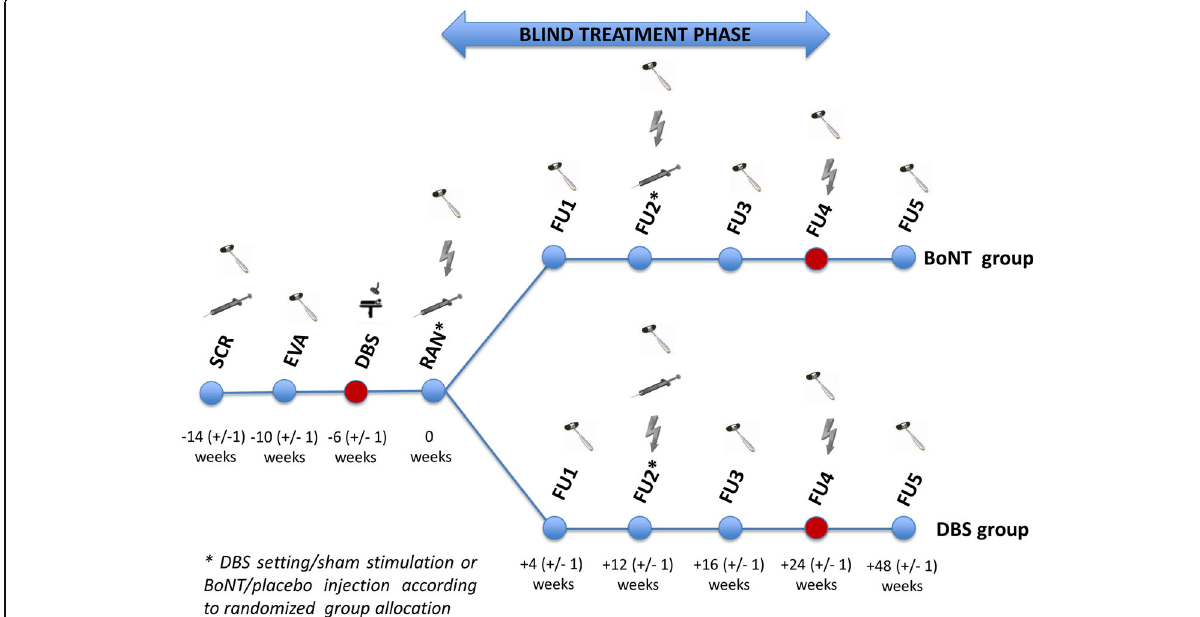
Fig. 1 Visit schedule of StimTox-CD: SCR = screening visit, EVA = evaluation visit, DBS = DBS surgery, RAN = randomization visit, FU = follow-up visit, icon “ syringe ” ≙ BoNT or placebo injection, icon “ reflex hammer ” ≙ clinical assessment, icon “ operating room ” ≙ DBS surgery, icon “ lightning ” ≙ DBS setting/sham